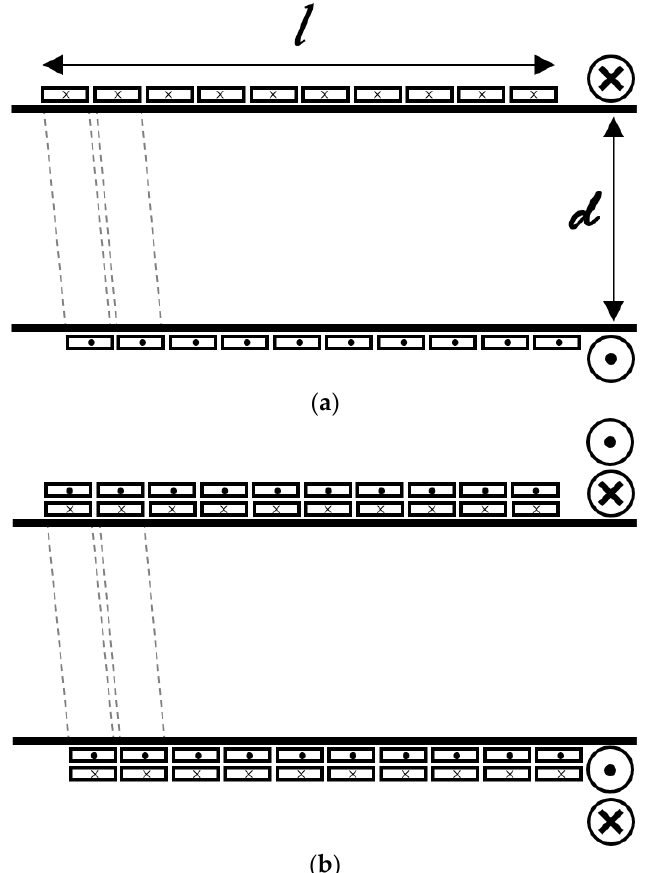
Figure 1. Cross sections of the helical-type winding method. ( a ) Original model; ( b ) Bifilar method.